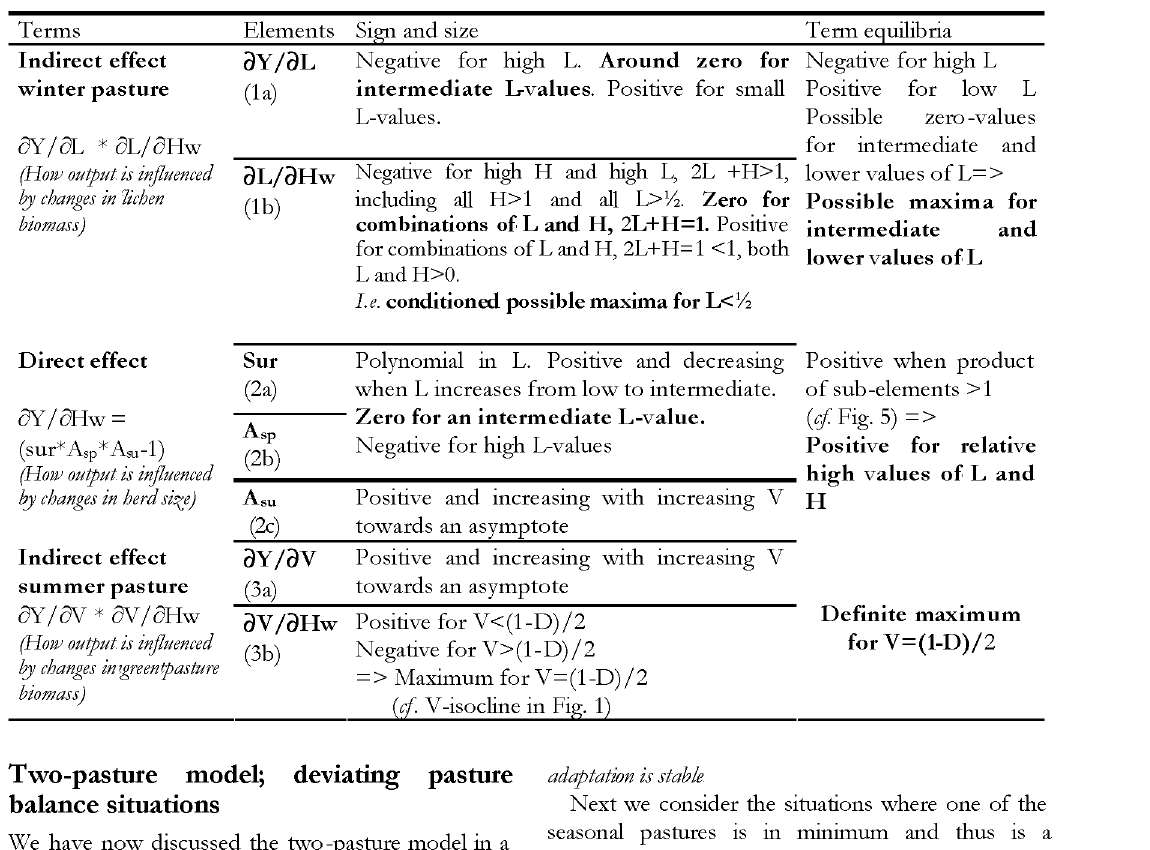
Table 3. Effects on output, Y, of changes in winter herd, Hw (cf. Appendix